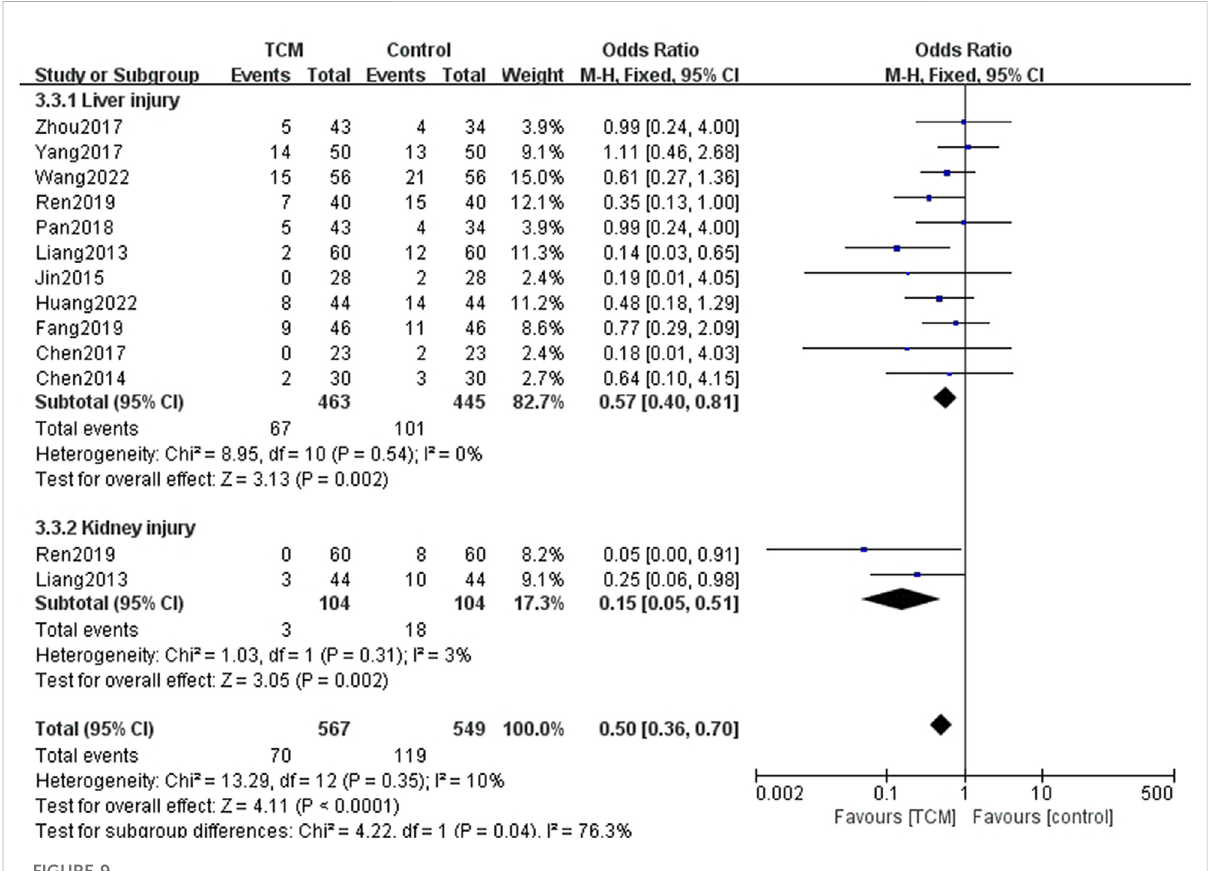
FIGURE 9 Forest plots and subgroup analysis for liver and kidney injury